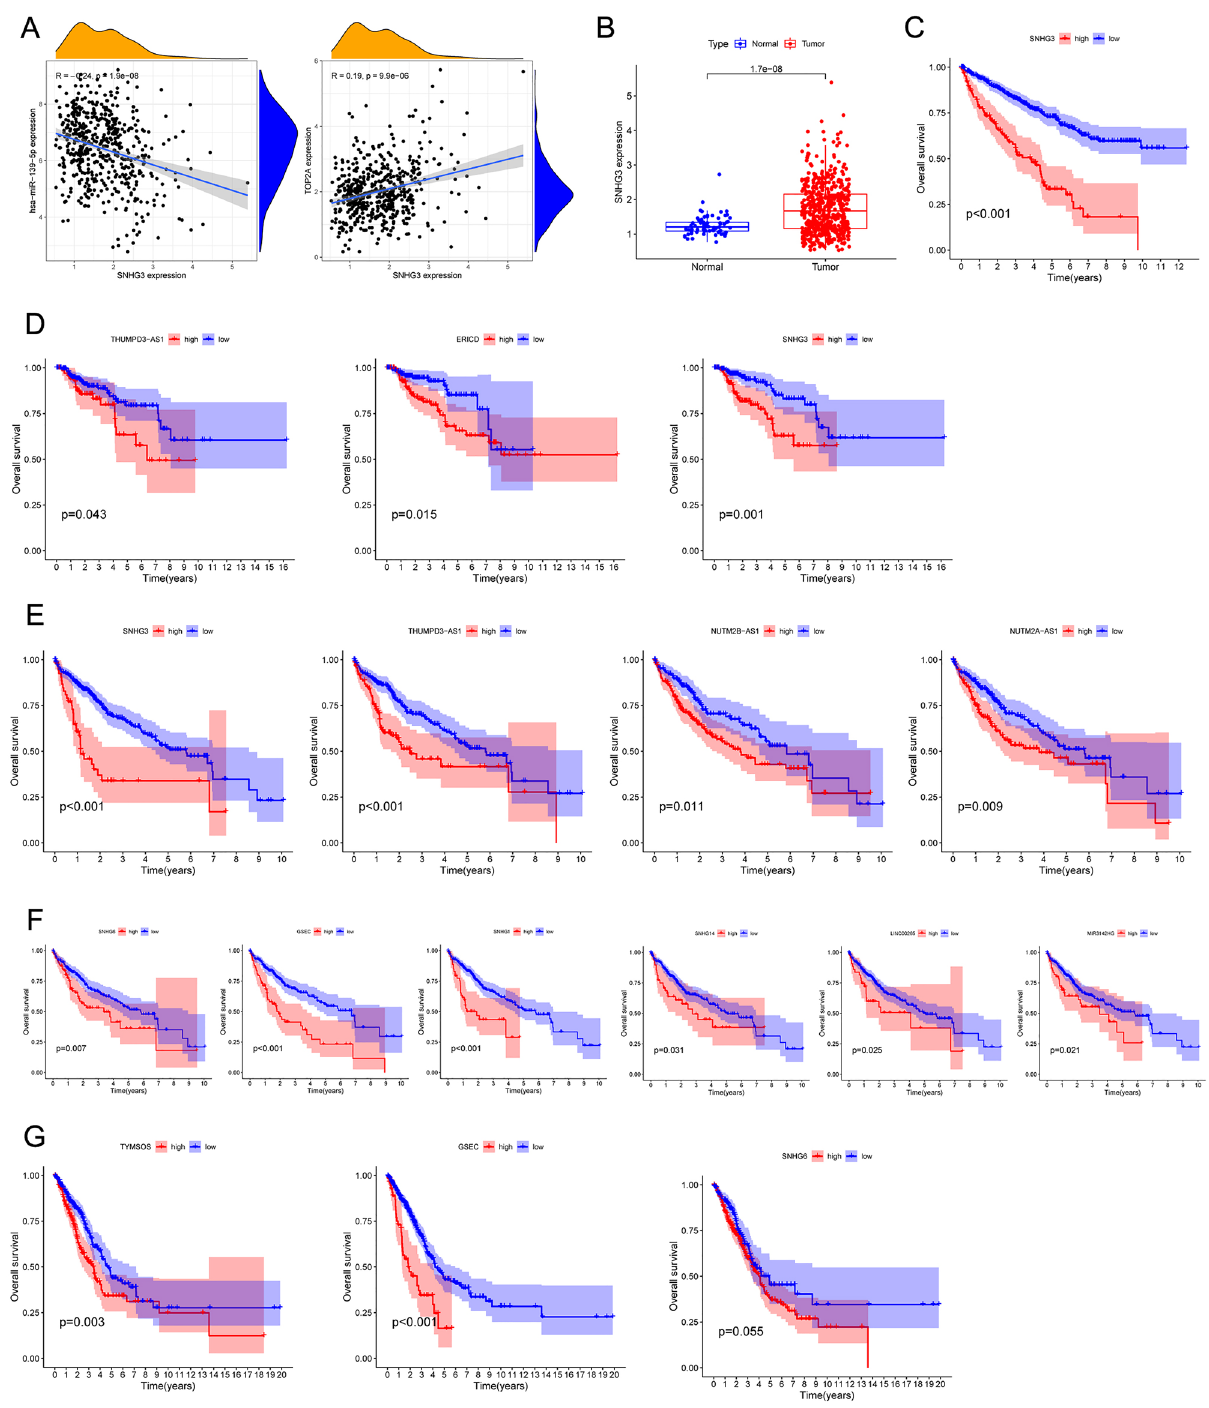
Figure 6. Predictive analysis of upstream lncRNAs of TOP2A -bound miRNAs. All miRNA expression was shown as log 2 (miRNA + 1). ( A ) Correlation of SNHG3 expression with miR-139-5p (left) and TOP2A (right) in KIRC. ( B ) The expression of SNHG3 in KIRC and normal tissues. ( C ) Overall survival analysis based on SNHG3 expression in KIRC. ( D ) Overall survival analysis based on miR-139-5p-bound lncRNAs (THUMPD3-AS1, ERICD and SNHG3) expression in KIRP. ( E ) Overall survival analysis based on miR-139- 5p-bound lncRNAs (SNHG3, THUMPD3-AS1, NUTM2B-AS1 and NUTM2A-AS1) expression in LIHC. ( F ) Overall survival analysis based on miR-101-3p-bound lncRNAs (SNHG6, GSEC, SNHG1, SNHG14, LINC00265, MIR3142HG) expression in LIHC. ( G ) Overall survival analysis based on miR-101-3p-bound lncRNAs (TYMSOS and GSEC, and SNHG6) expression in